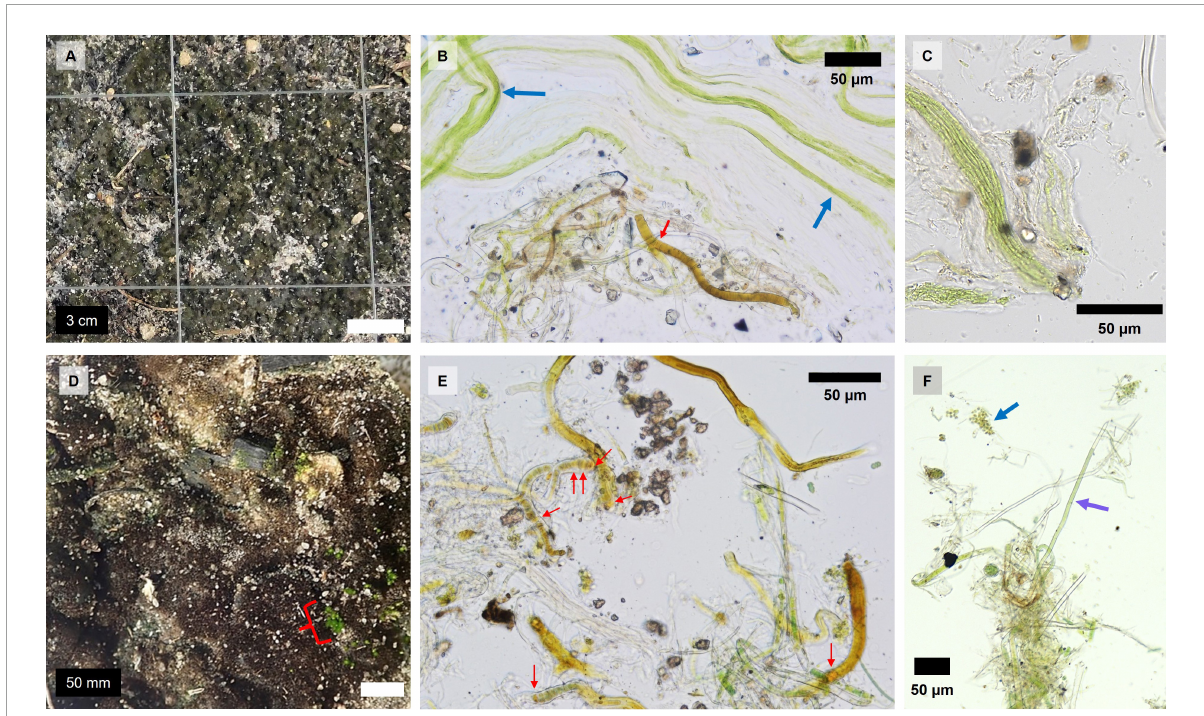
FIGURE1 Images and micrographs of Grape and Citrus biocrusts: (A) Grape biocrust close-up, (B) filamentous algae bundles next to a heterocystous cyanobacterial filament in Grape, (C) non-heterocystous cyanobacterial bundles in Grape, (D) Citrus biocrust close-up with moss pointed out with a red bracket, (E) heterocystous filamentous cyanobacteria in Citrus, and (F) non-heterocystous cyanobacterial filament and unicellular algae in Citrus. Red arrows point to heterocystous cells, the blue arrow points to a group of unicellular algae, and the purple arrow points to a non-heterocystous cyanobacterial